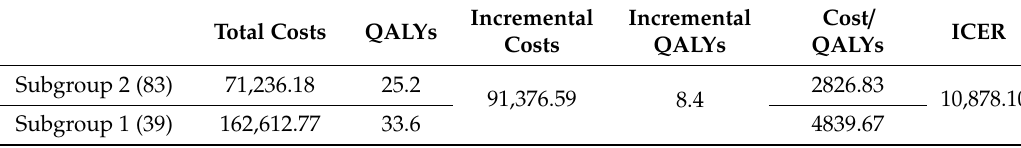
Incremental Incremental Cost / ICER Costs QALYs QALYs 2826.83 91,376.59 8.4 10,878.10